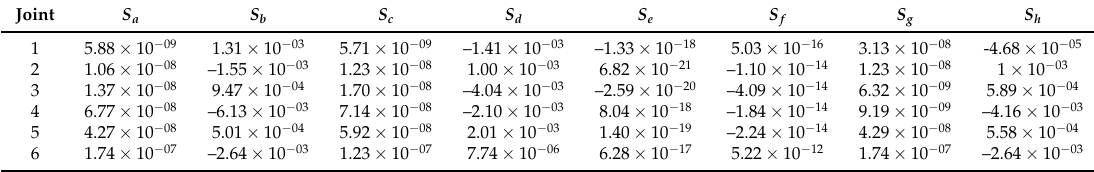
Table 1. Parameters for the linear functions of the compliance models for the robot Kuka KR270.